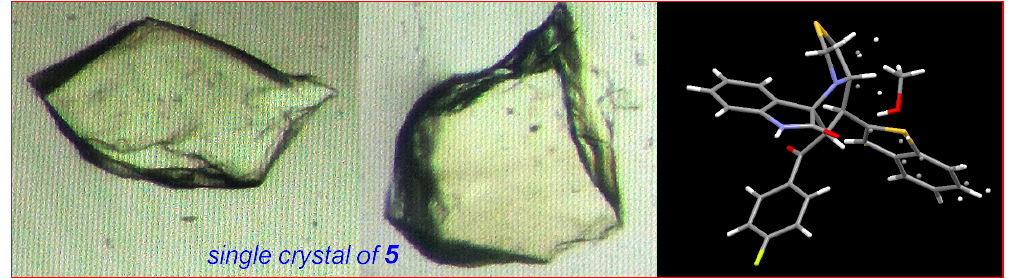
Figure 1. Single crystal and 3D structure of compound 5.